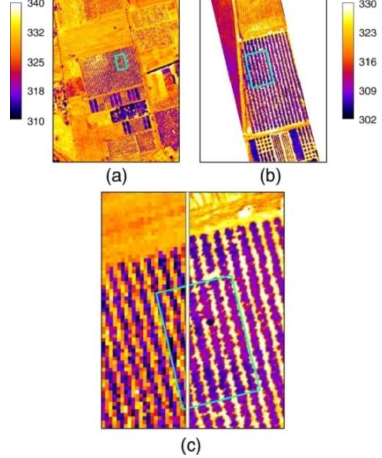
Figure 4. Airborne thermal imagery acquired over the study site: ( a ) AHS image collected at 12:30GMT on 16 July 2005; ( b ) UAV image collected at 13:30 GMT on 23 August 2007; ( c ) image detail showing the spatial resolution differences of AHS (2 m) against the UAV (40 cm). The spatial resolution of the UAV imagery shows individual tree crown, enabling pure crown temperature extraction. Data from